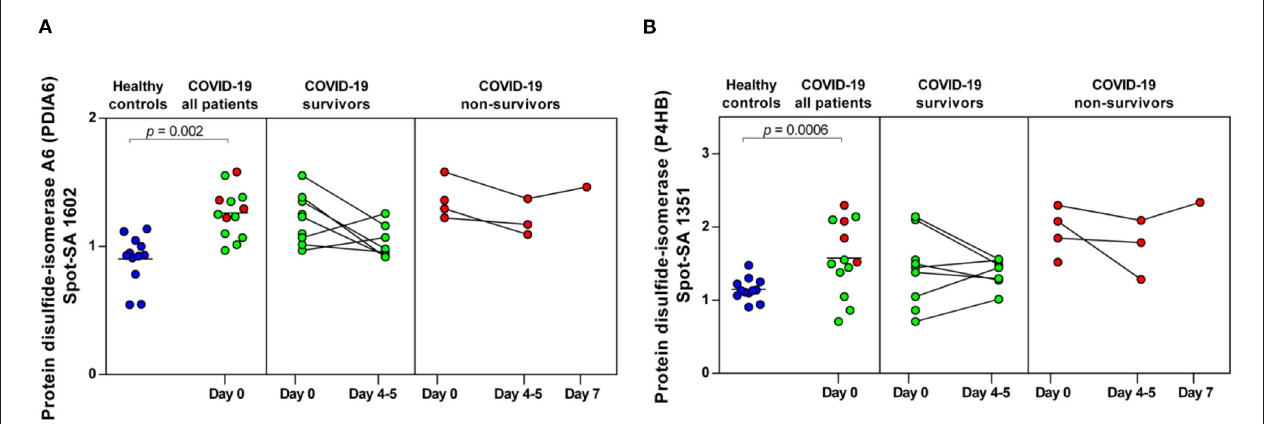
FIGURE 6 | COVID-19-dependent course of the abundance of PDIA6 and P4HB in platelets. (A) Protein levels of PDIA6 (spot 1602) and (B) of P4HB (spot 1351). Scatter dot plot and time course of COVID-19 patients of PDIA6 and P4HB standardized platelet protein spot abundance quantified by 2D-DIGE (healthy controls: n = 12; COVID-19 survivors: n = 9; COVID-19 non-survivors: n = 4). 2D-DIGE, two-dimensional differential in-gel electrophoresis.